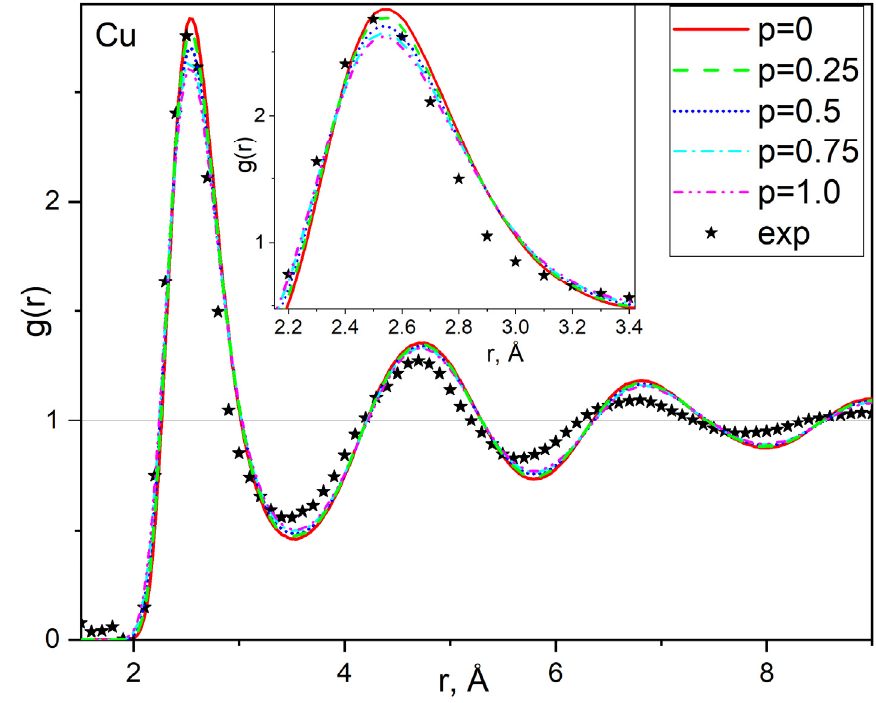
Figure 4. Pair correlation functions of liquid Cu at T = 1423 K and different p in comparison with experiment [38].